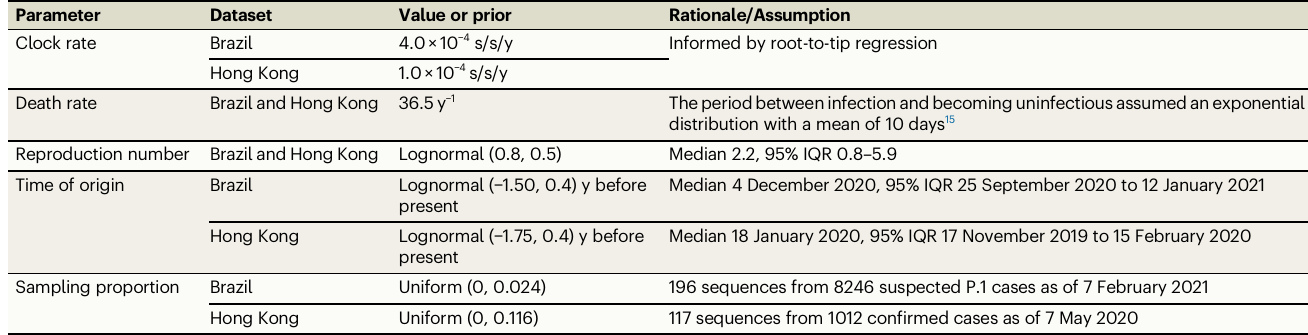
Table 3 | Values and priors for the parameters of the BDSKY model. s/s/y=substitutions per site per year Parameter